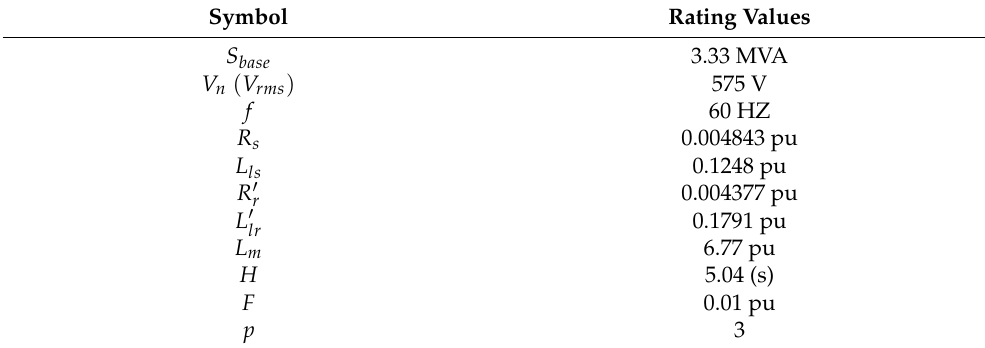
Table A3. SCIG parameters.